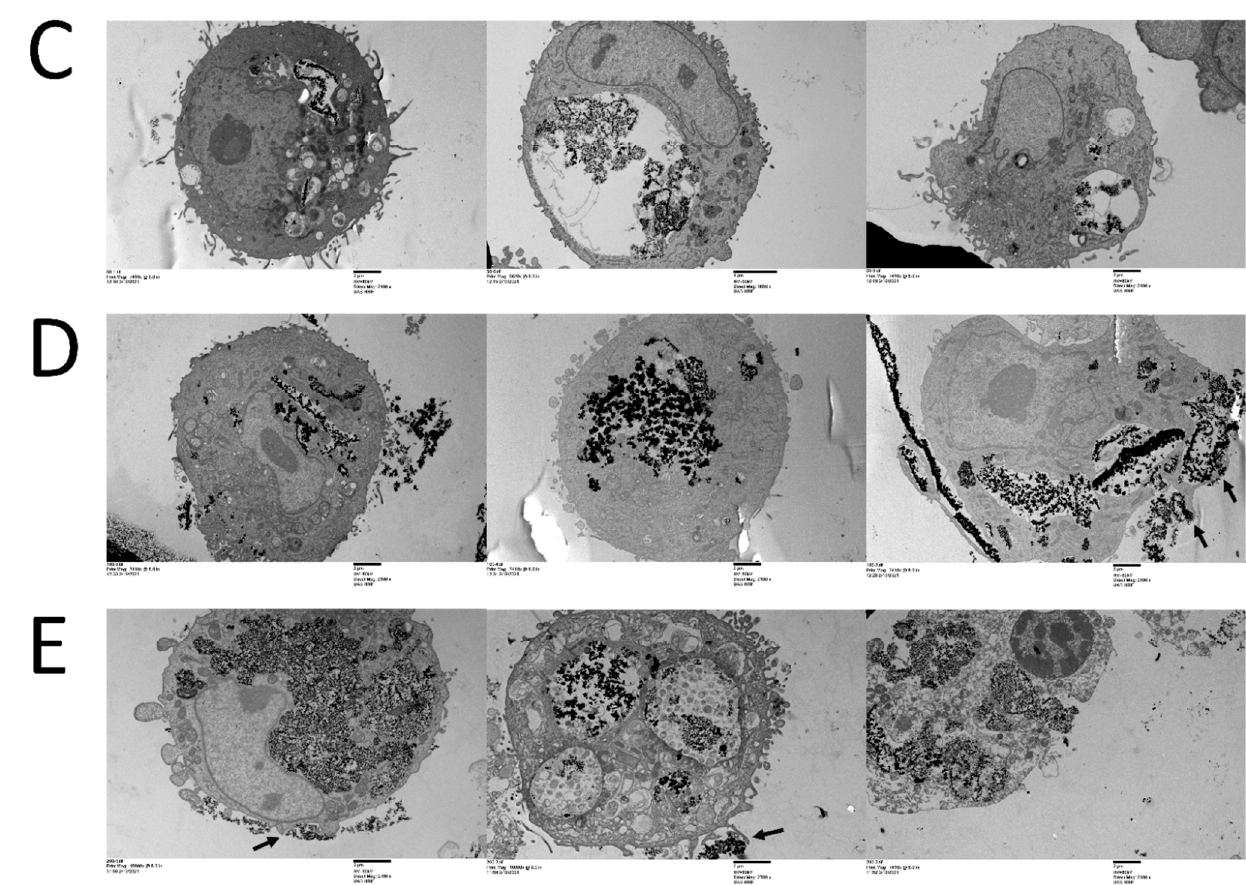
Figure 1. Compartmental visualization of CeO 2 nanoparticles in MDA MB231 breast carcinoma cells. Random representative image samples of cells treated with ( A ) 0, ( B ) 25, ( C ) 50, ( D ) 100, or ( E ) 200 μ g ml − 1 of CeO 2 nanoparticles visualized under transmission electron microscopy.